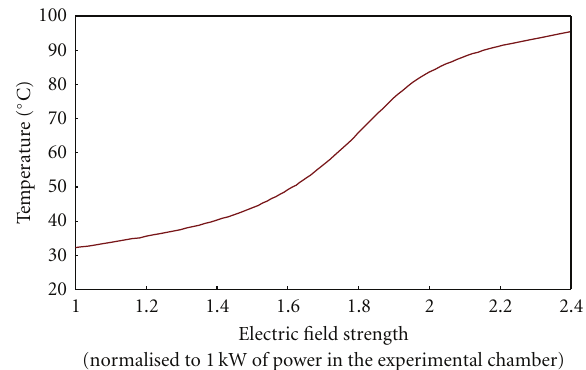
Figure 15: Temperature versus applied microwave field strength (in clay/loam soil after 25 seconds of heating time) [26,